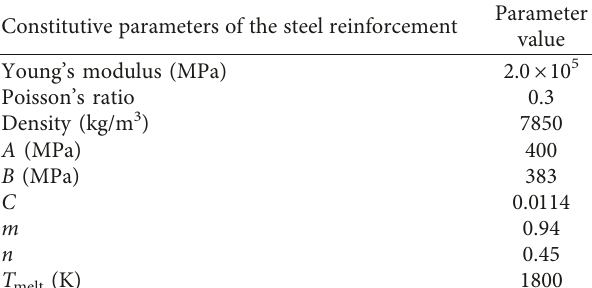
Table 5: Material parameters of the Johnson–Cook model for the steel